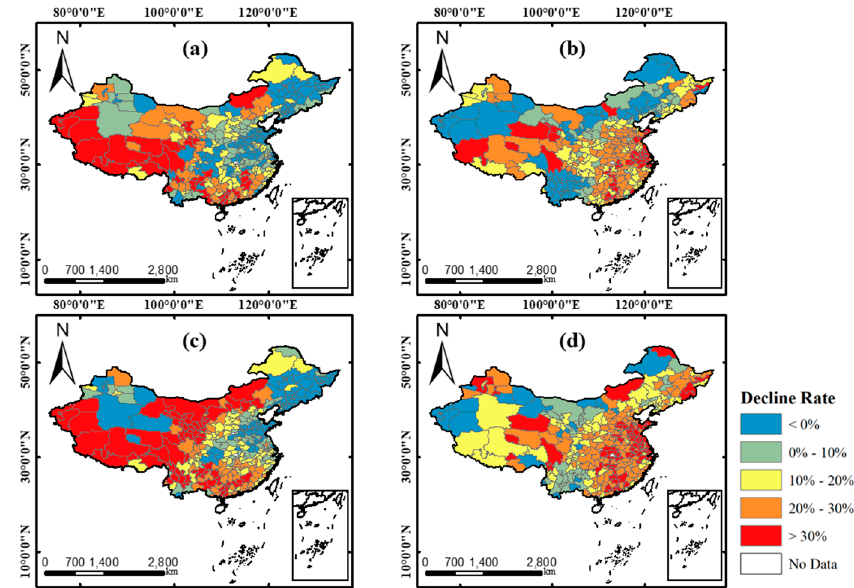
Figure 4. Decline rates of PM 2.5 and PM 10 . ( a ),( b ) The drPM 2.5 in 2018–2019 and 2019–2020, respectively. ( c ),( d ) The drPM 10 in 2018–2019 and 2019–2020, respectively.